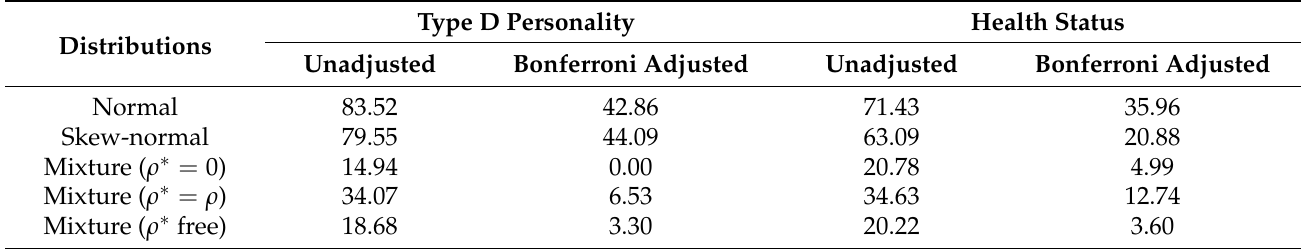
Table 3. Rejection percentages of each distribution across all pairs of